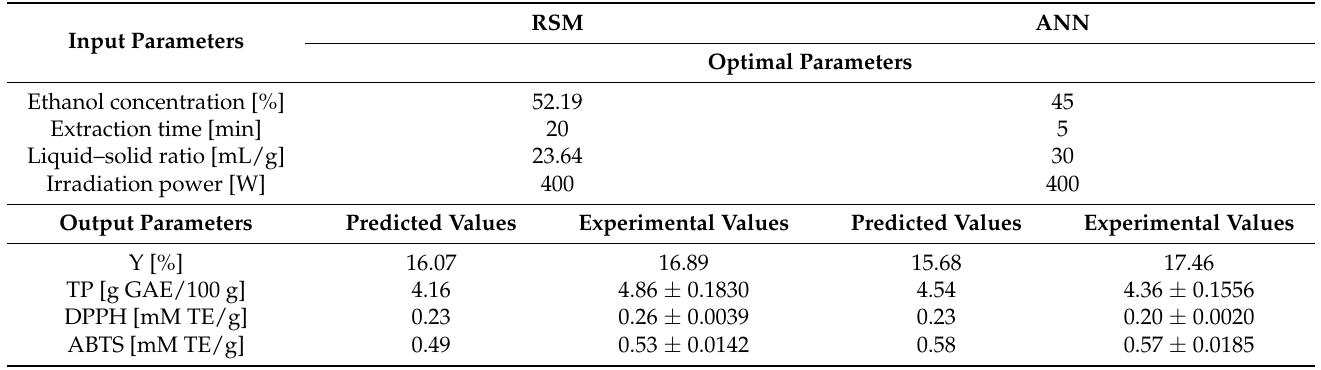
Table 5. Predicted and experimental values of investigated responses obtained at optimal conditions according to RSM and ANN